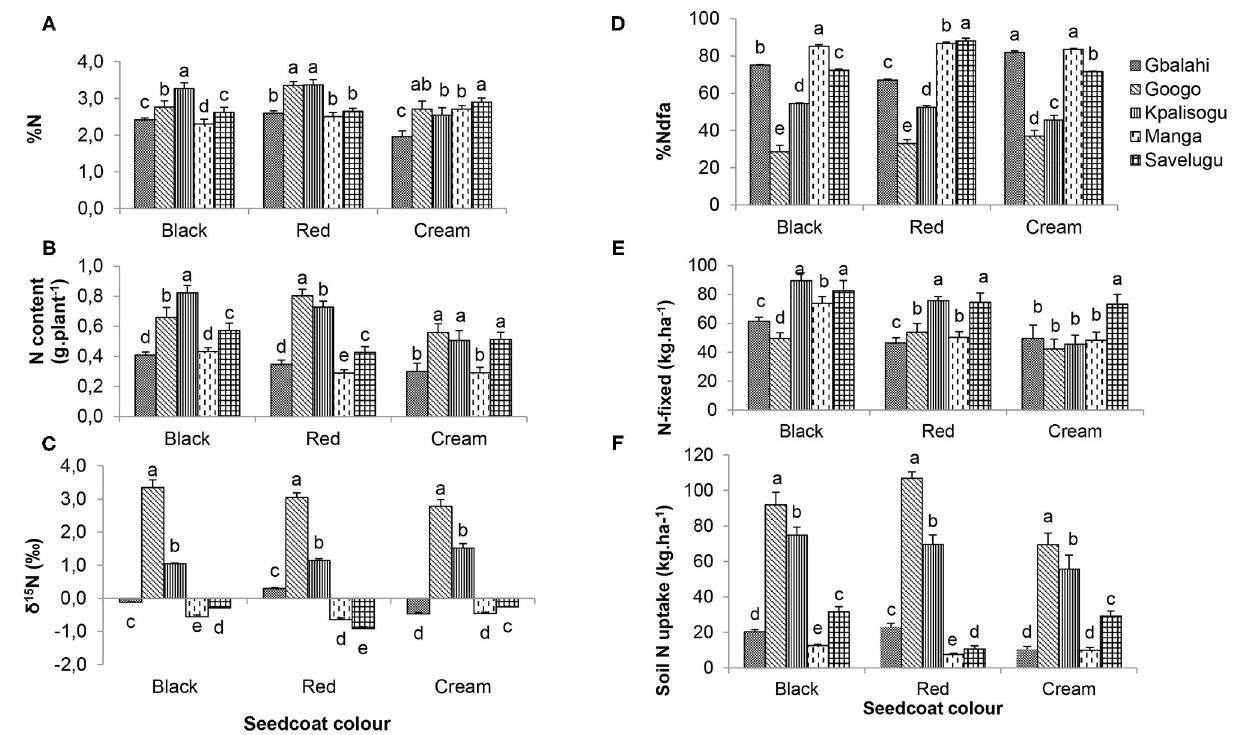
FIGURE 2 | Interactive effects of seedcoat colour × environment on (A) shoot %N, (B) shoot N content, (C) shoot δ 15 N, (D) %Ndfa, (E) amount of N-fixed, and (F) soil N uptake of Bambara groundnut plants sampled at 56 DAP. Bars with dissimilar letters are significantly different.